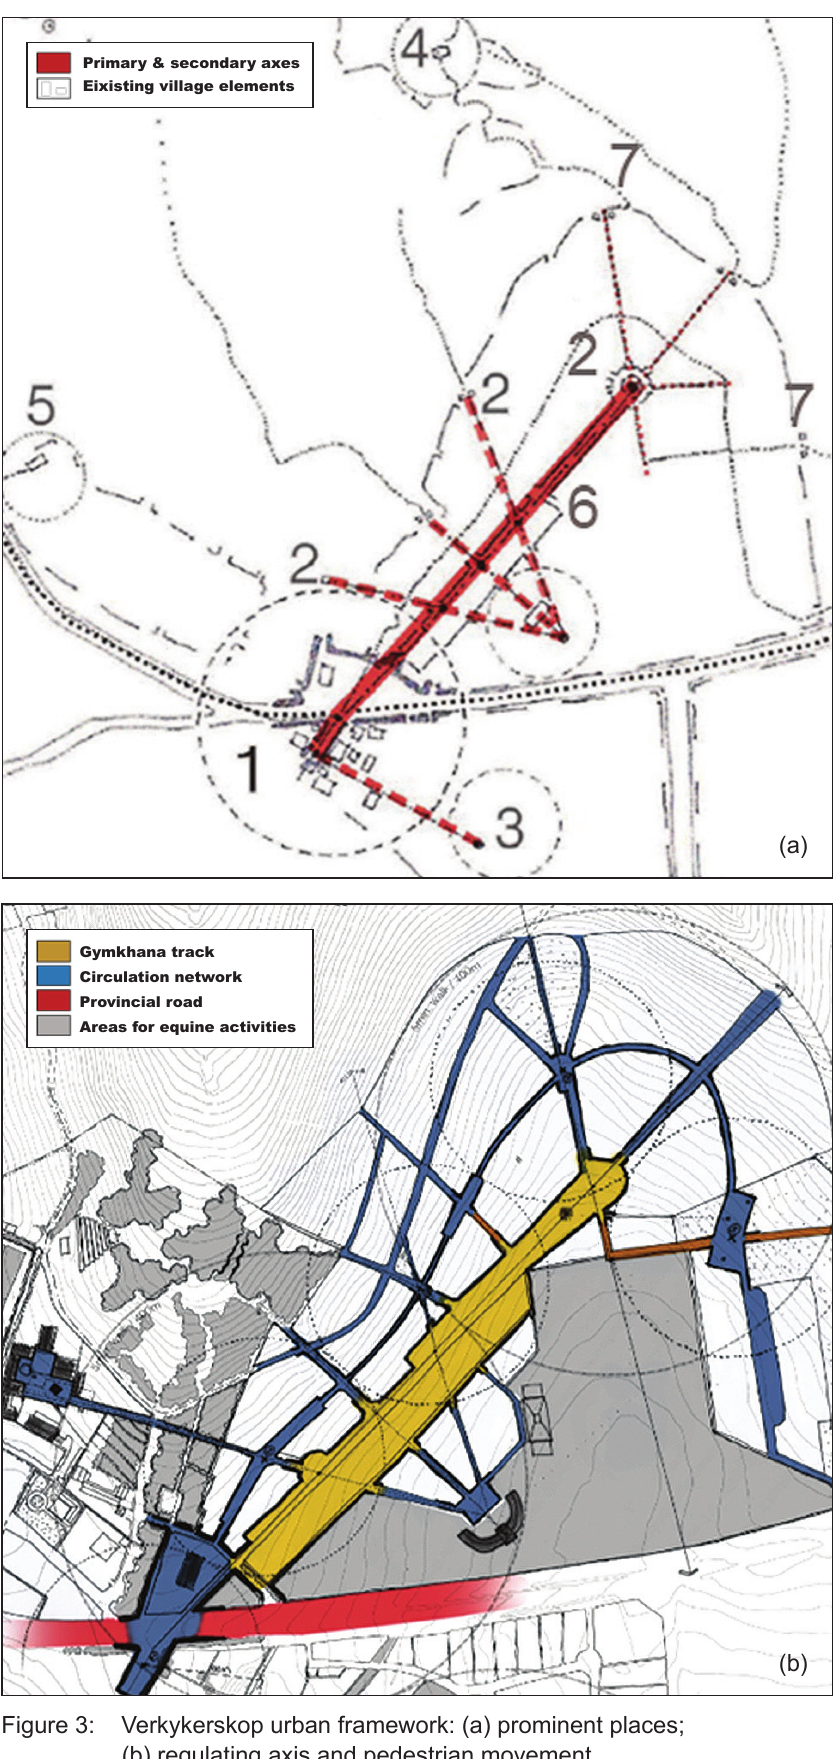
Figure 3: Verkykerskop urban framework: (a) prominent places; (b) regulating axis and pedestrian